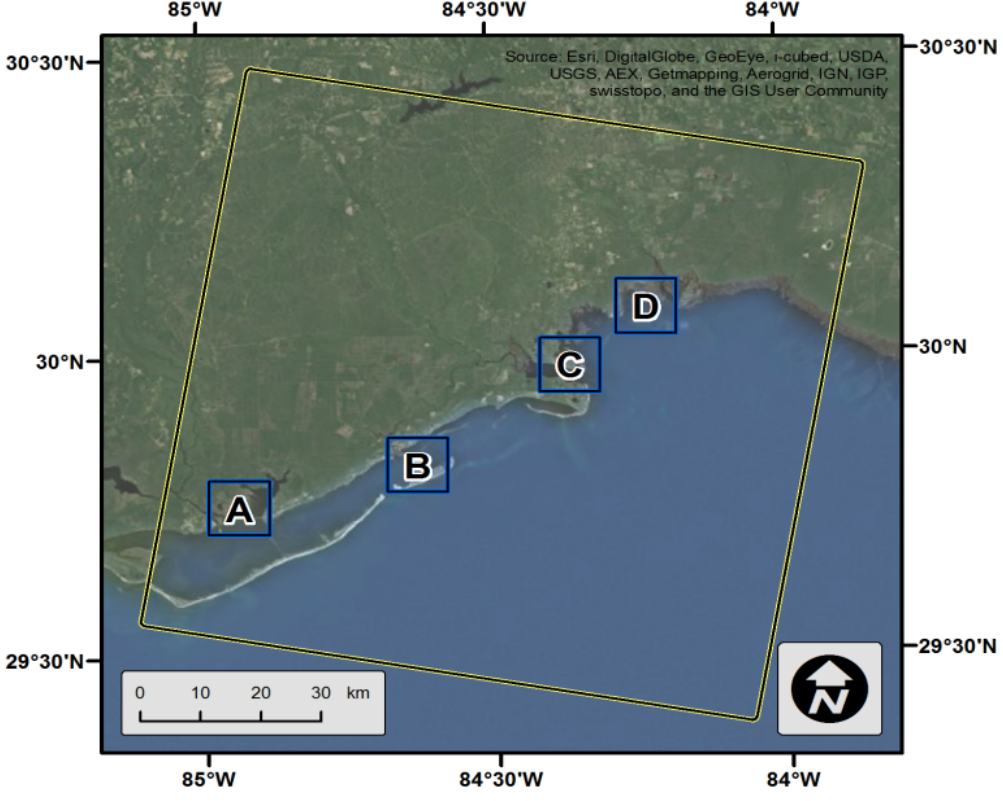
Figure 3. Synergetic method assessment areas (blue squares) within the Radarsat scene boundary (yellow).